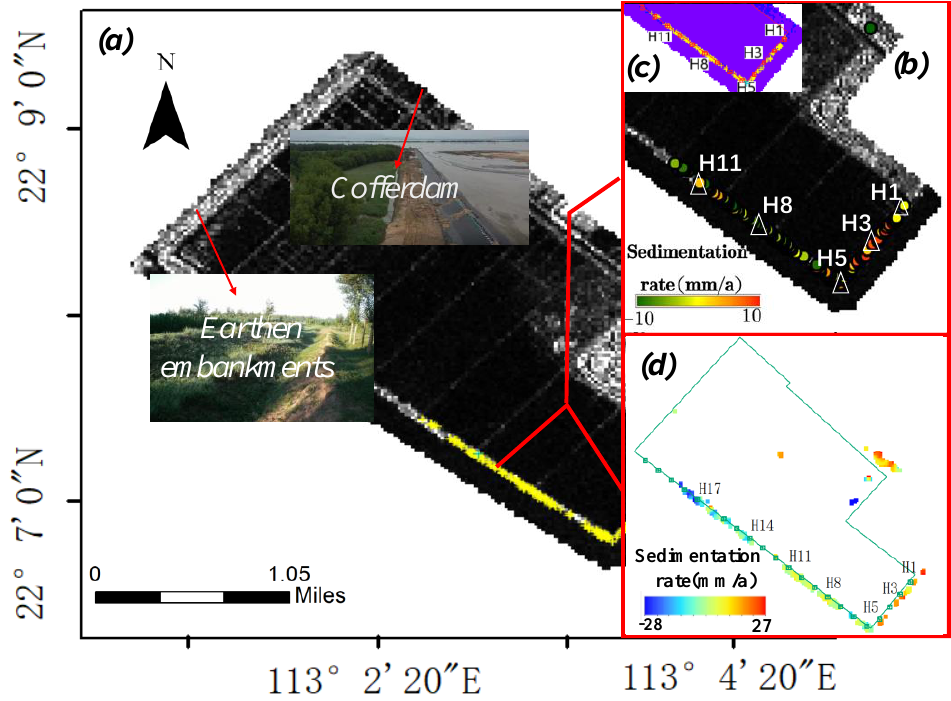
Figure 13. TS-InSAR deformation velocity field in the sludge area (The yellow part of ( a ) is the PS point in the sludge area, ( b ) is the deformation rate of PS point in the vertical direction (unit: mm/a),H1-H11 is the leveling monitoring point, ( c ) is the average deformation situation in this area and the relative position of the leveling point. ( d ) is the vertical deformation of the ground obtained by SBAS-InSAR).